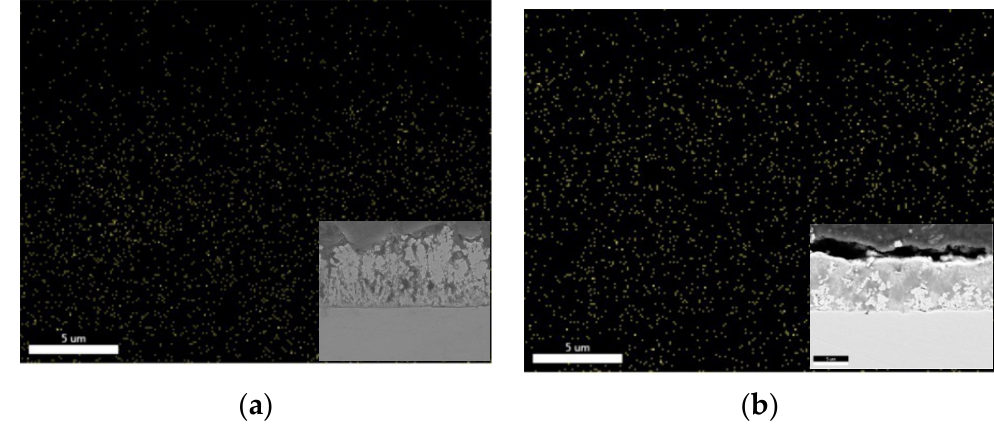
Figure 13. EDAX mapping of cerium in Zn-Co-CeO 2 coatings deposited under ultrasound at 2 A dm − 2 from solutions containing ( a ) 0.2 wt.% CeO 2 powder and ( b ) 0.2 wt.% CeO 2 sol, all elements. Cross-section SEM images are shown as inserts.